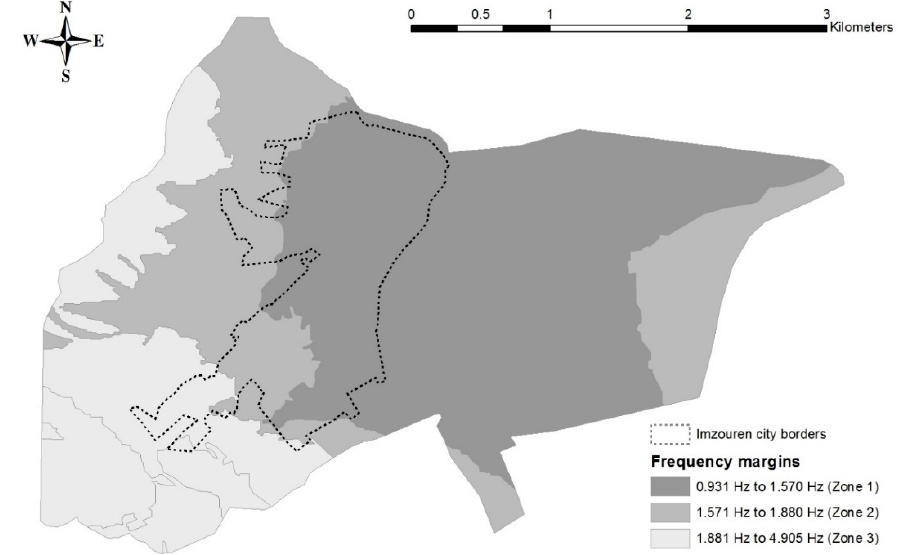
Figure 2. Spatial distribution of frequencies and identification of homogeneous areas in the town of Imzouren [30].